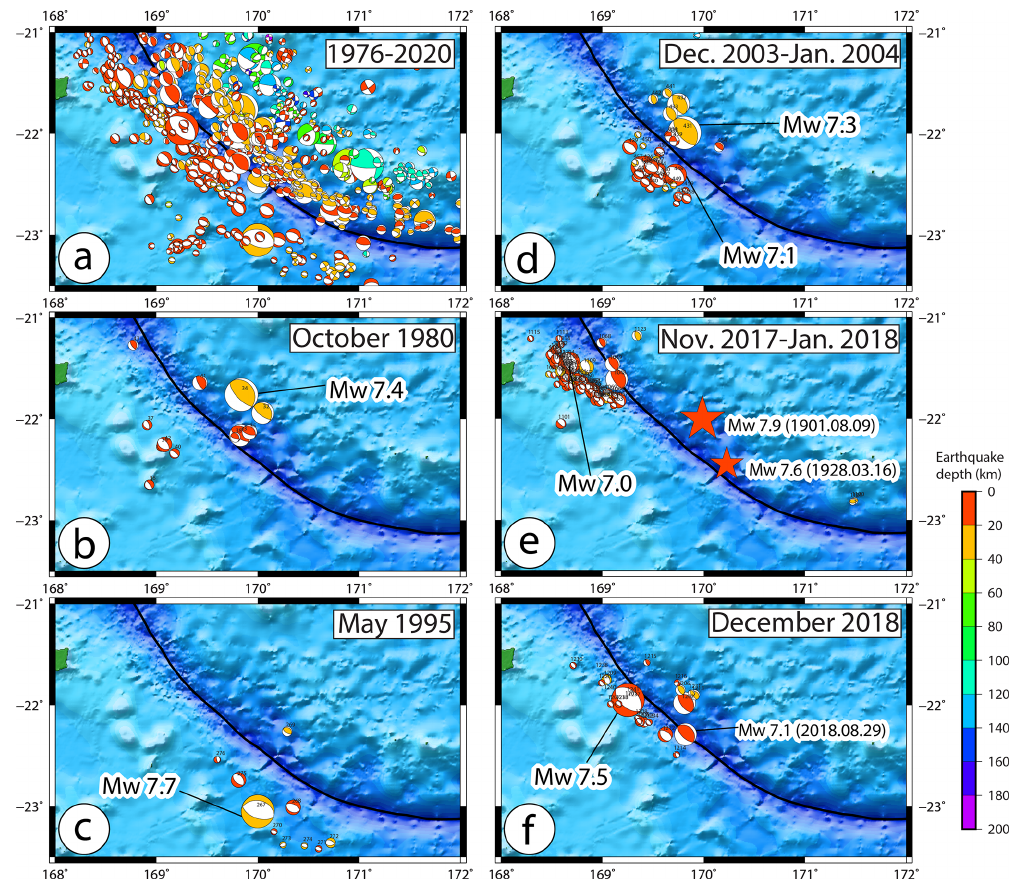
Figure 2. Focal mechanism solutions from the GCMT project plotted for the period 1976–2020 with focus on five different seismic crises showing nine large shallow earthquakes at the Loyalty Ridge–Vanuatu Arc subduction zone.